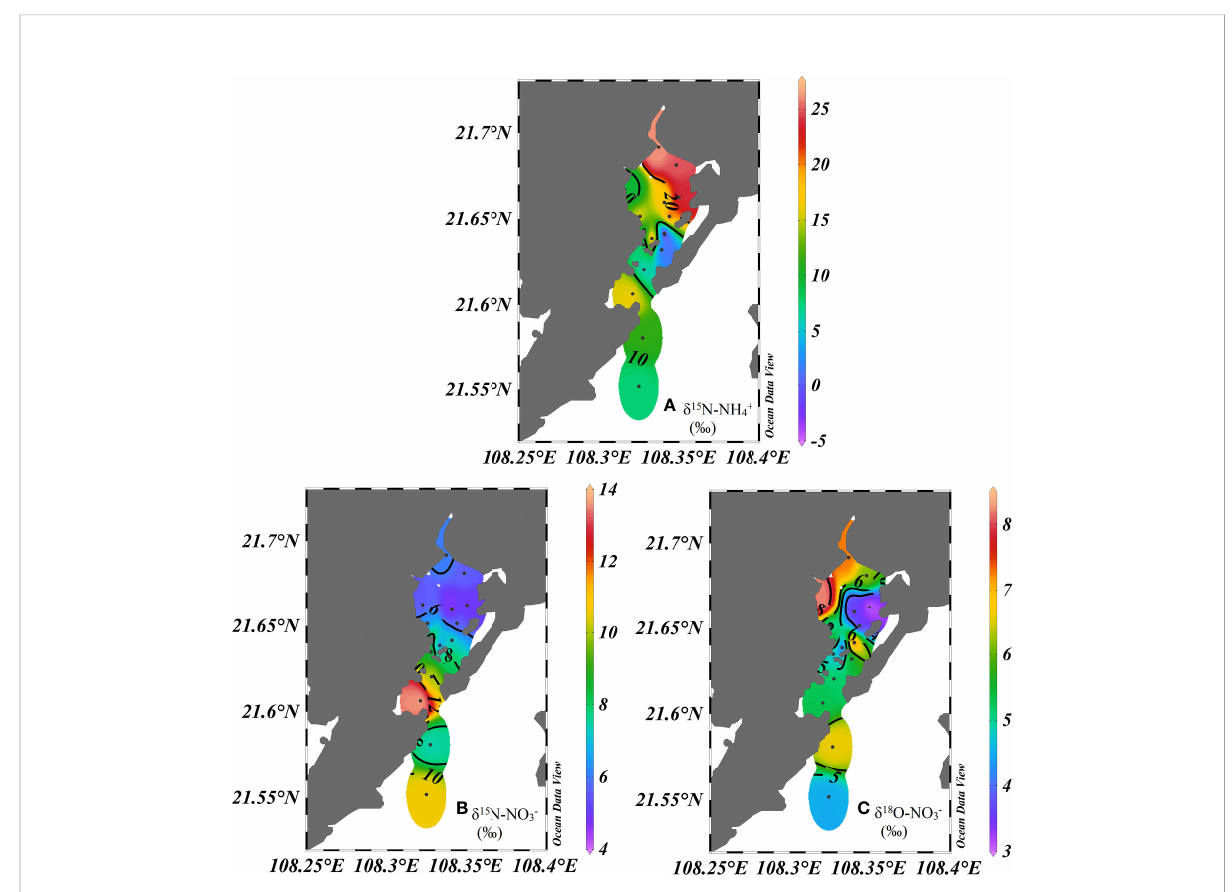
FIGURE 4 Spatial distributions of nutrients in Xi Bay during the rainy season. (A) , d 15N-NO 3- (B) , d 18O-NO 3 - (C) , d 15N-NH4